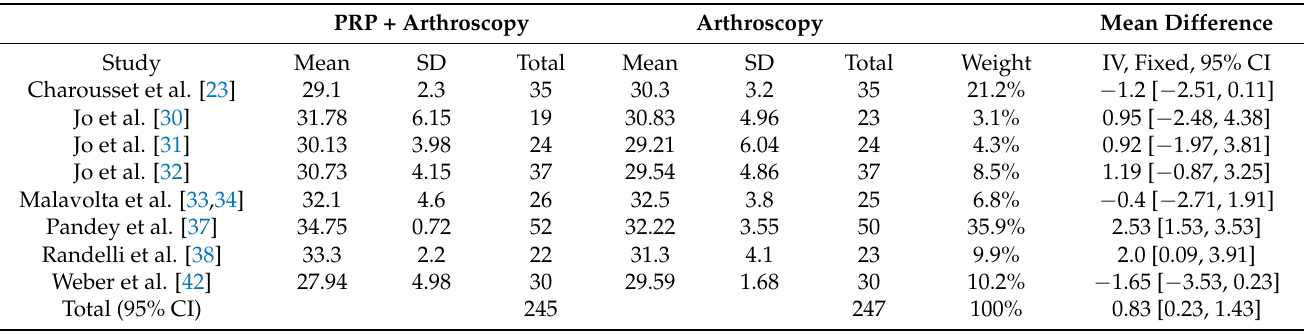
Table 6. Comparison of post-operative UCLA scores between PRP and control groups at final